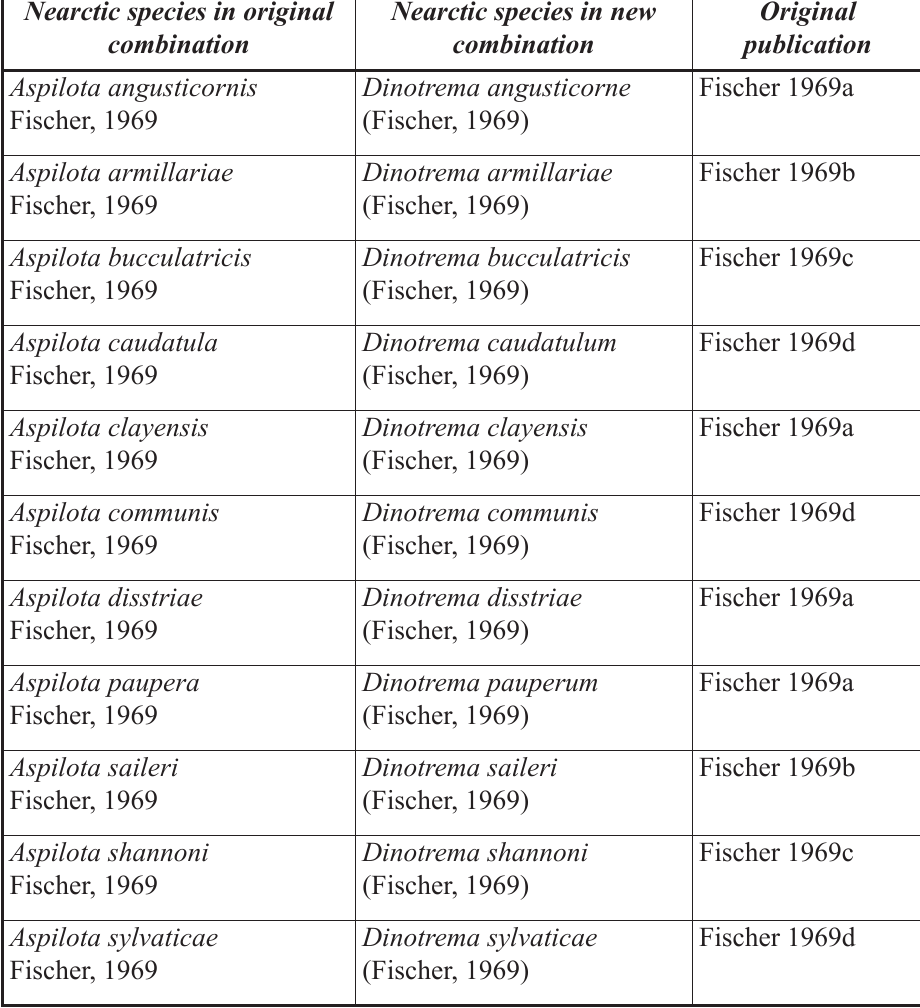
Table 1. List of new combinations presented in this paper, with their original name and